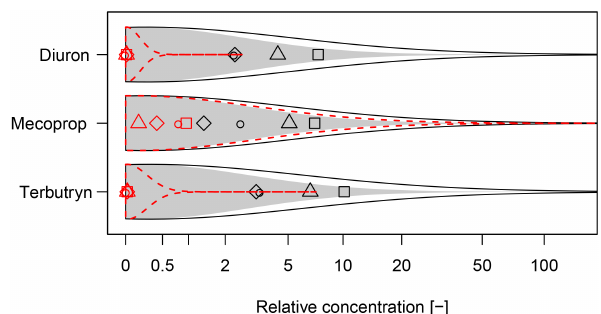
Figure 7. Ensemble future predictions for biocides under man- agement alternatives “all” (red) and “CurrPrac” (black), compared to present (grey). Distributions were normalized to be comparable across variables. Open symbols indicate mean concentrations of in- dividual scenarios: circle: “status quo”; square: “moderate growth”; diamond: “exploding growth”; pyramid: